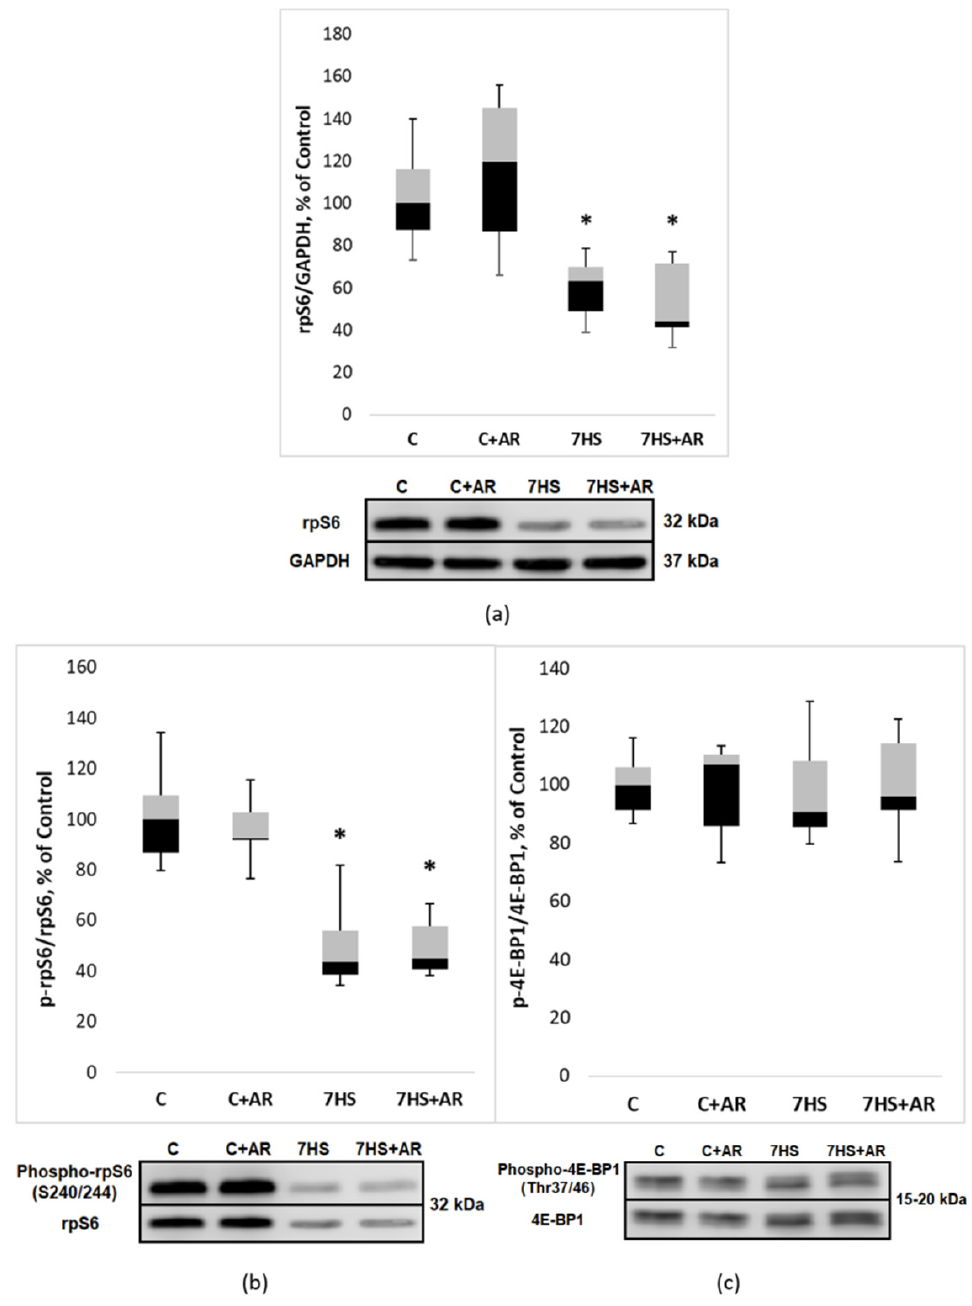
Figure 6. Effect of GSK-3 inhibition during 7-day unloading on rpS6 abundance ( a ) and phosphorylation status of rpS6 ( b ) and 4E-BP1 ( c ) in rat soleus muscle. Data are presented as median, interquartile range, minimum and maximum values, expressed as % of control. C, vivarium control group, C + AR, vivarium control rats + daily injections of GSK-3 inhibitor (AR-A014418) for 7 days, 7HS, hindlimb suspension for 7 days, 7HS + AR, 7-day hindlimb suspension + daily injections of GSK-3 inhibitor (AR-A014418), *: p < 0.05 vs. C.